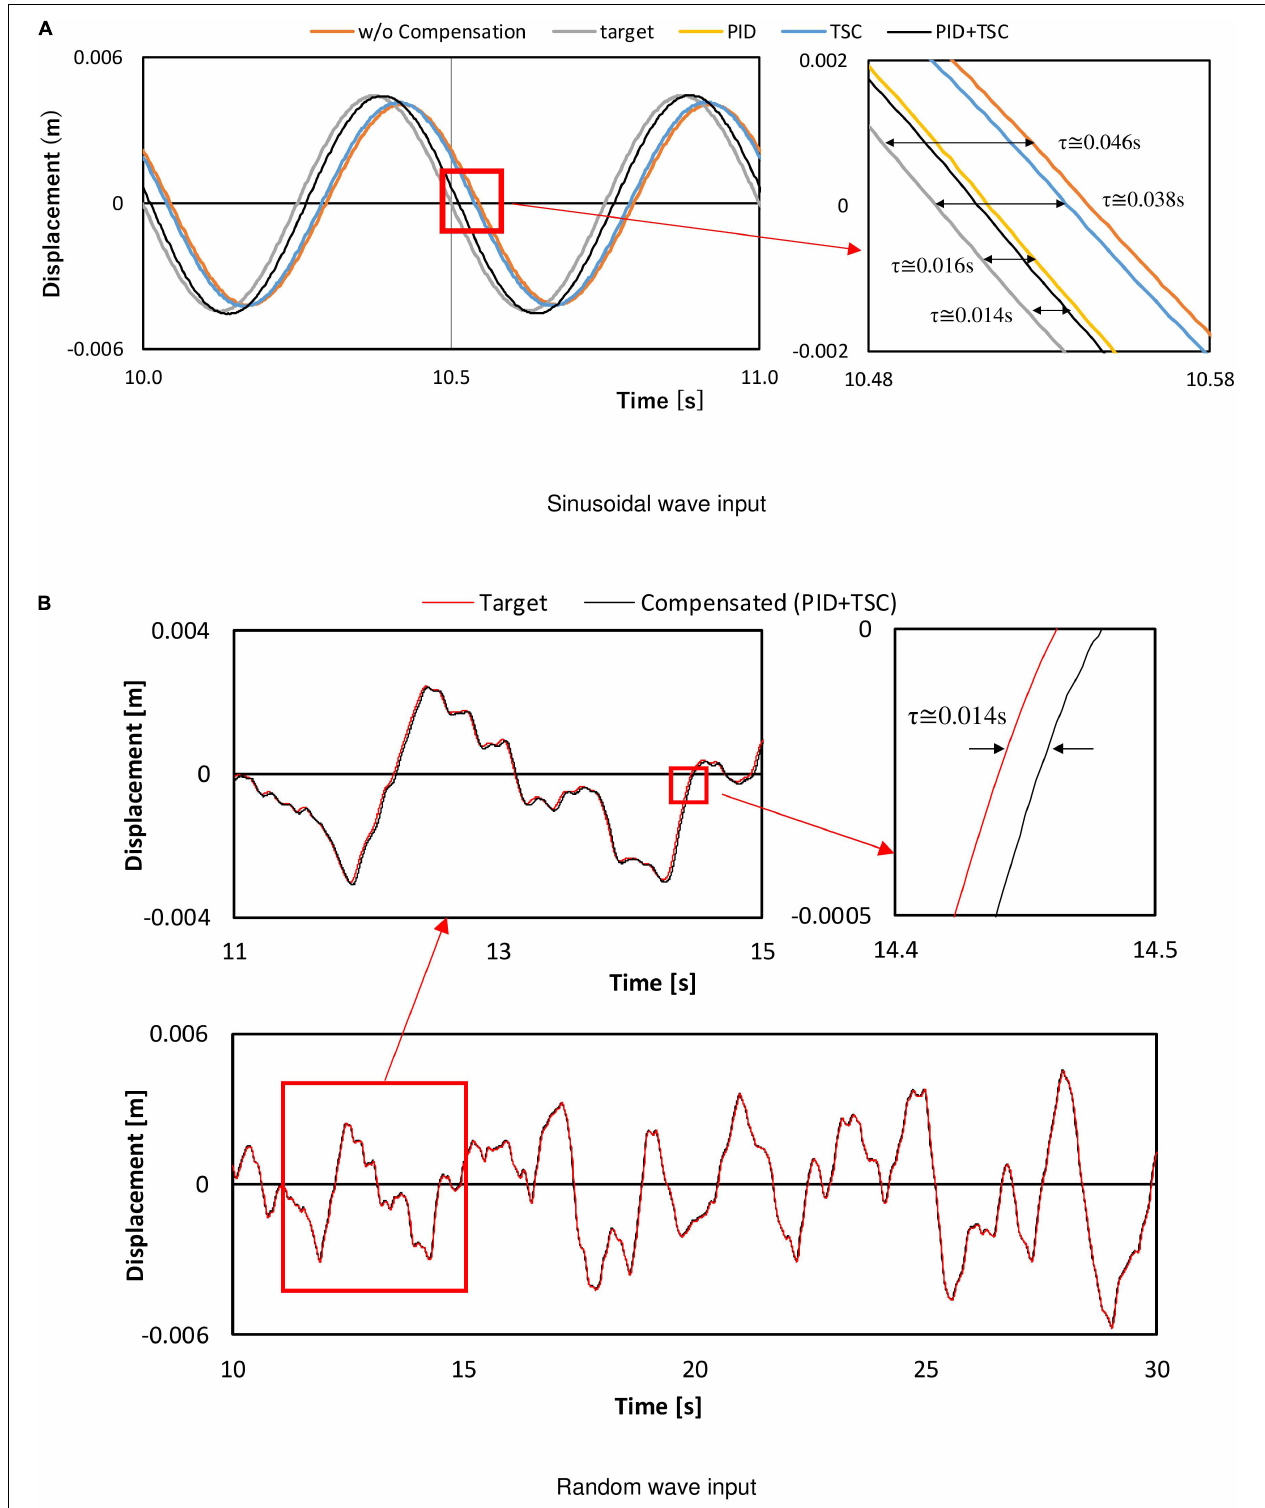
FIGURE 7 | Displacement compensation results of hydraulic actuator motion using PID and TSC. (A) Sinusoidal wave input. (B) Random wave input.